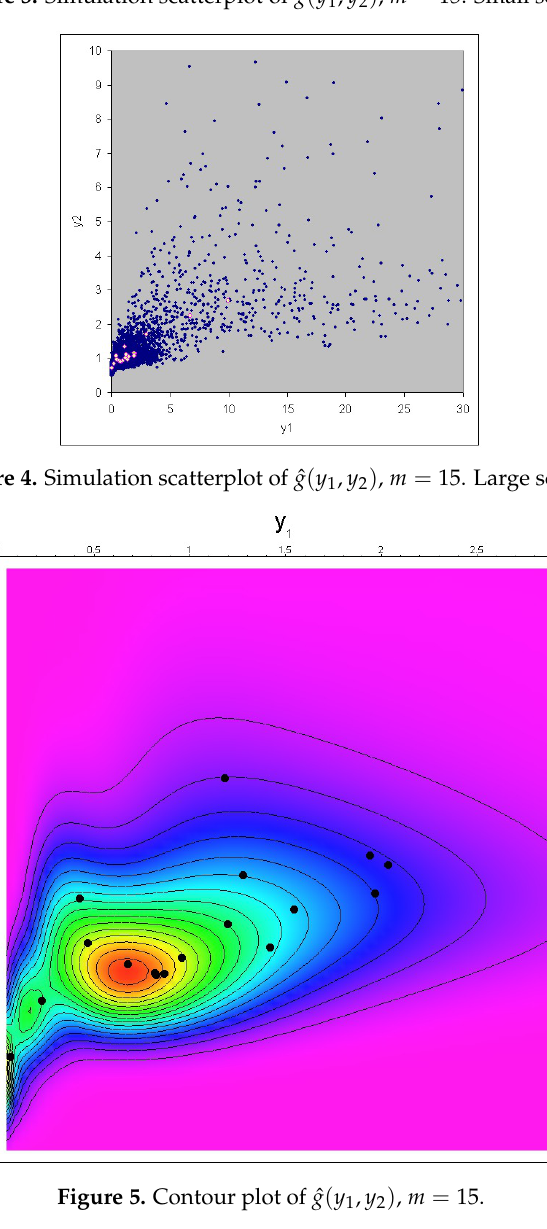
Figure 3. Simulation scatterplot of ˆ g ( y 1 , y 2 ) , m = 15. Small scale.